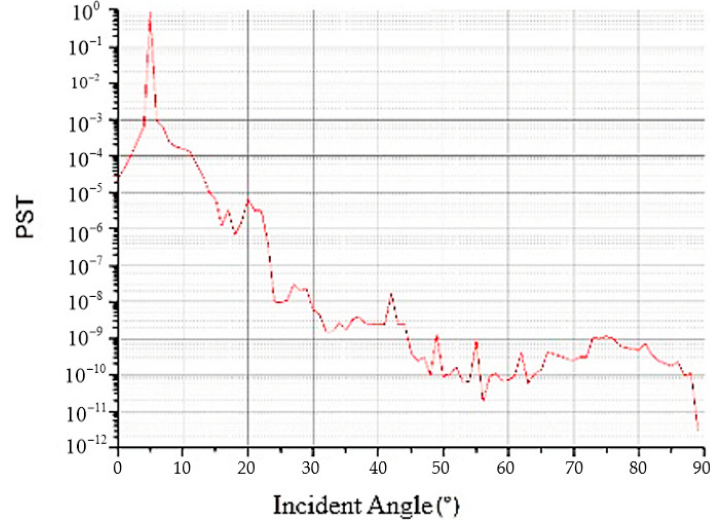
Figure 11. PST analysis curve of the system after installing the light barrier of the third mirror. Table 8. Simulation results of the VGI after installing the light barrier of the third mirror.